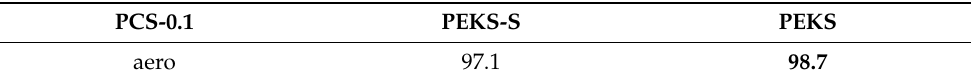
Table 6. Comparison with the state-of-the-art methods in terms of the Percentage of Correct Structures (PCS) metric on ObjectNet3D dataset. Bold number indicates the best results.